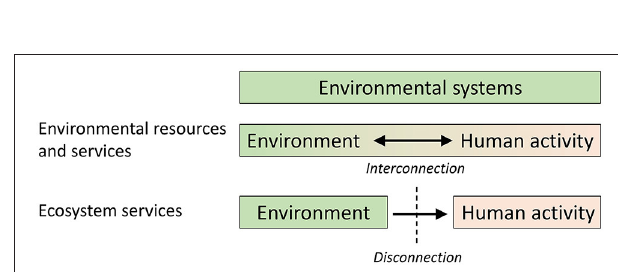
FIGURE 4 | Illustration of how environmental resources and services link together aspects of the physical environment and human activity, in contrast to many studies of ecosystem